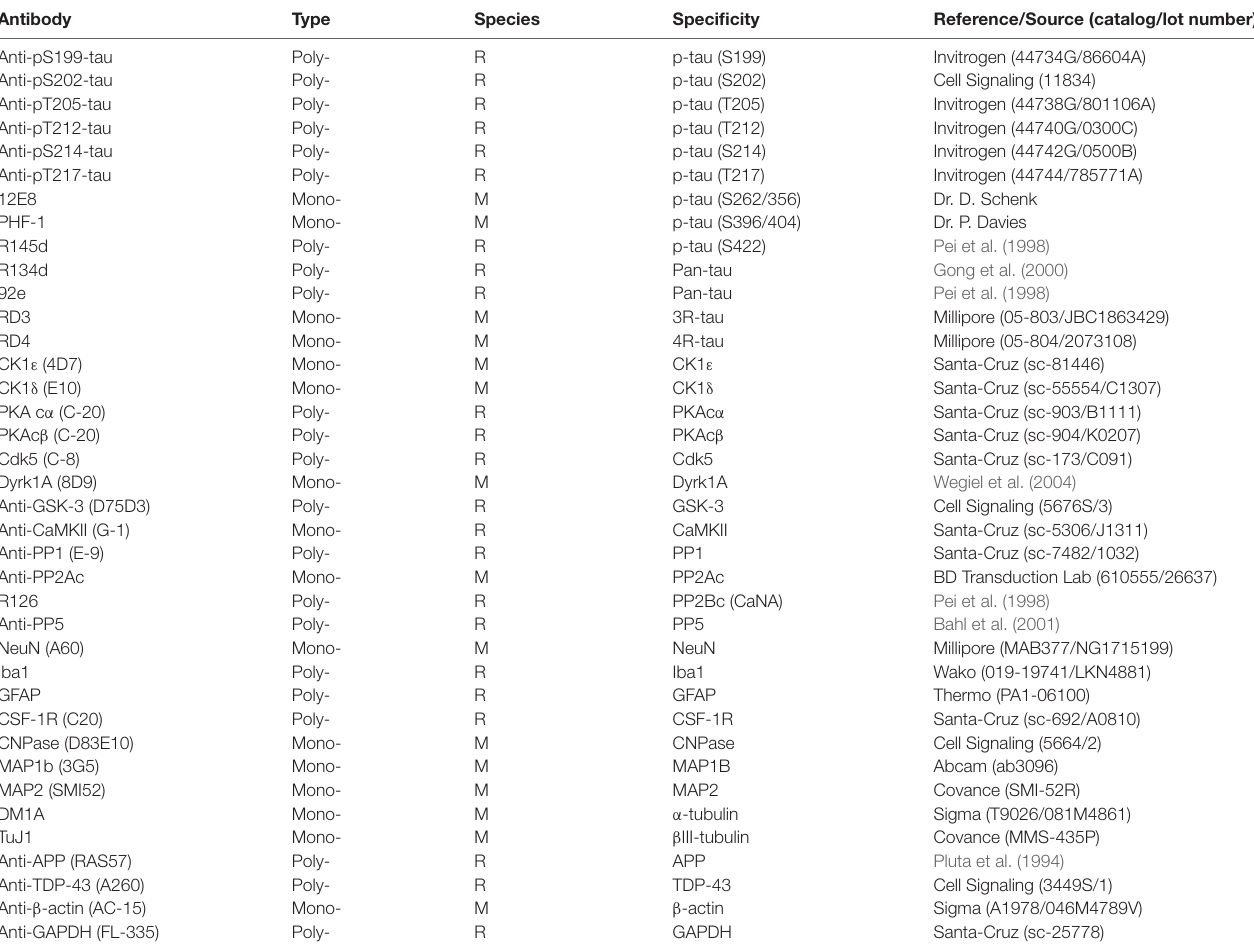
TABLE 2 | Primary antibodies employed in this study.